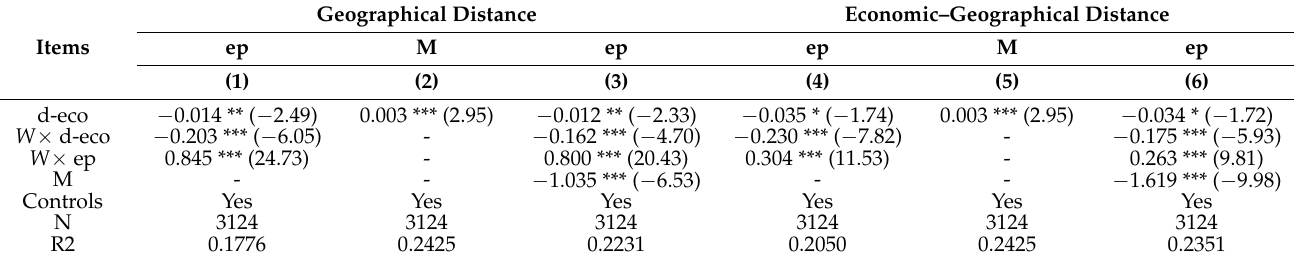
Table 7. Mechanism test of green development